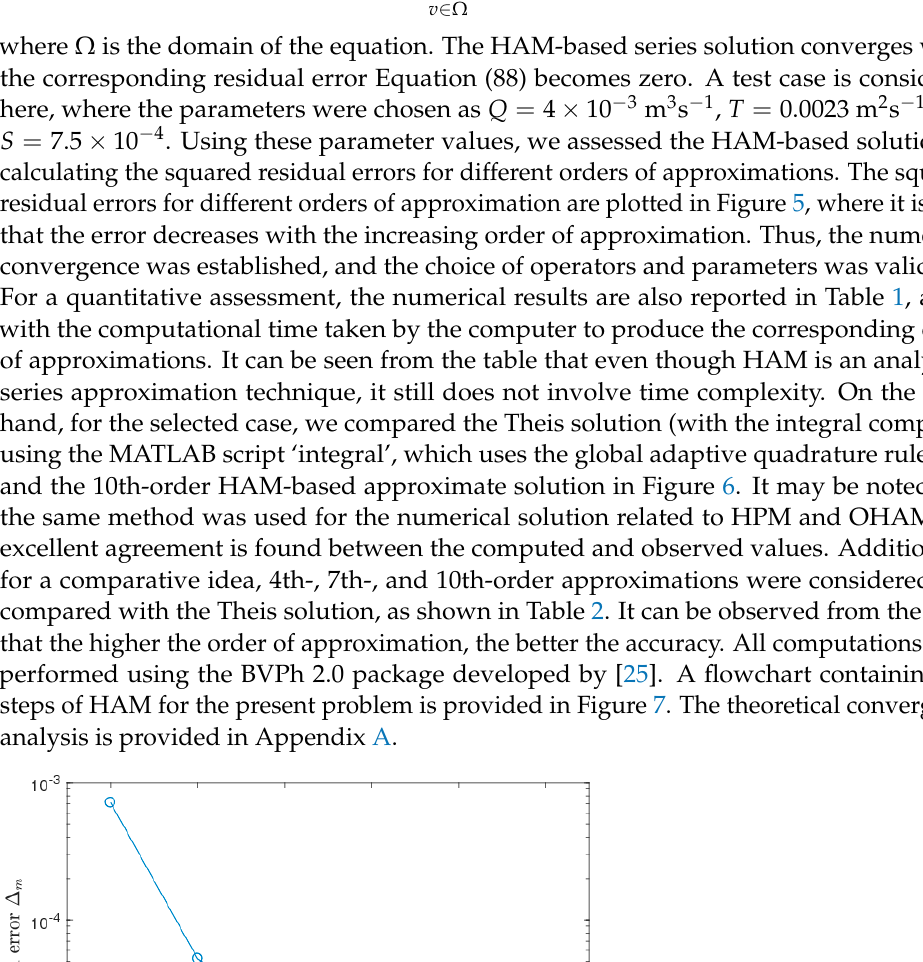
10.149 Figure 6. Comparison between the Theis solution and 10th-order HAM-based solution for the se- lected case.